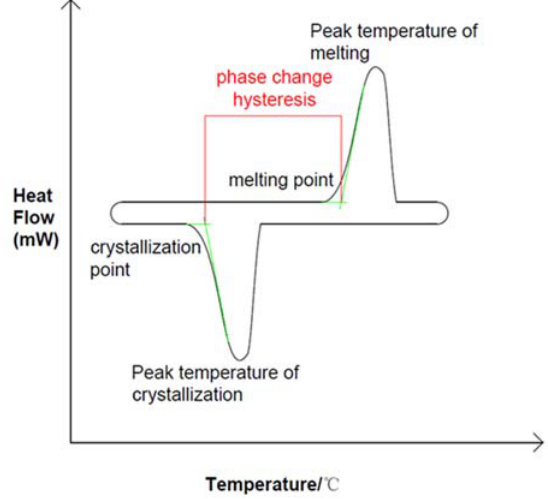
Figure 2. Phase transition hysteresis in DSC curve during actual phase transition, Reprinted with permission from ref. [10]. Copyright 2020